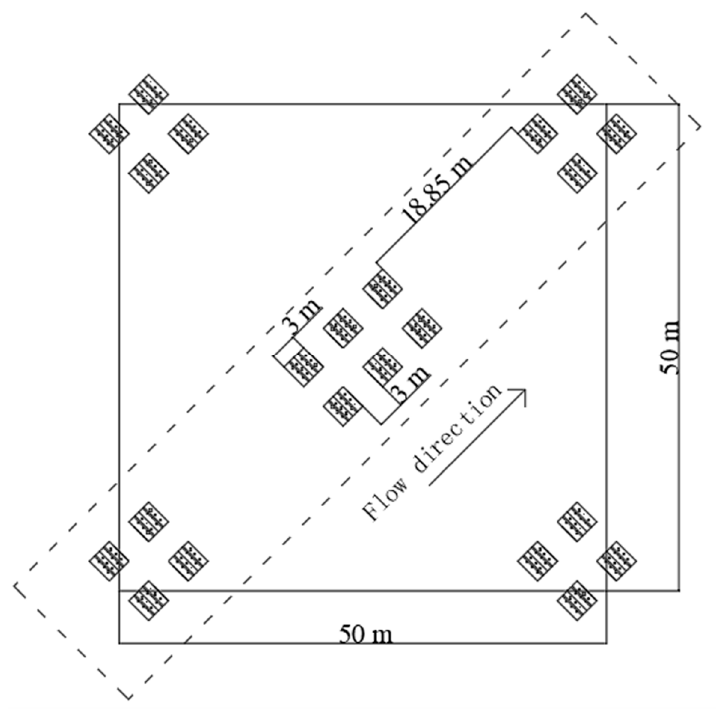
Figure 4. Schematic diagram of M-shaped artificial reef group prototype.